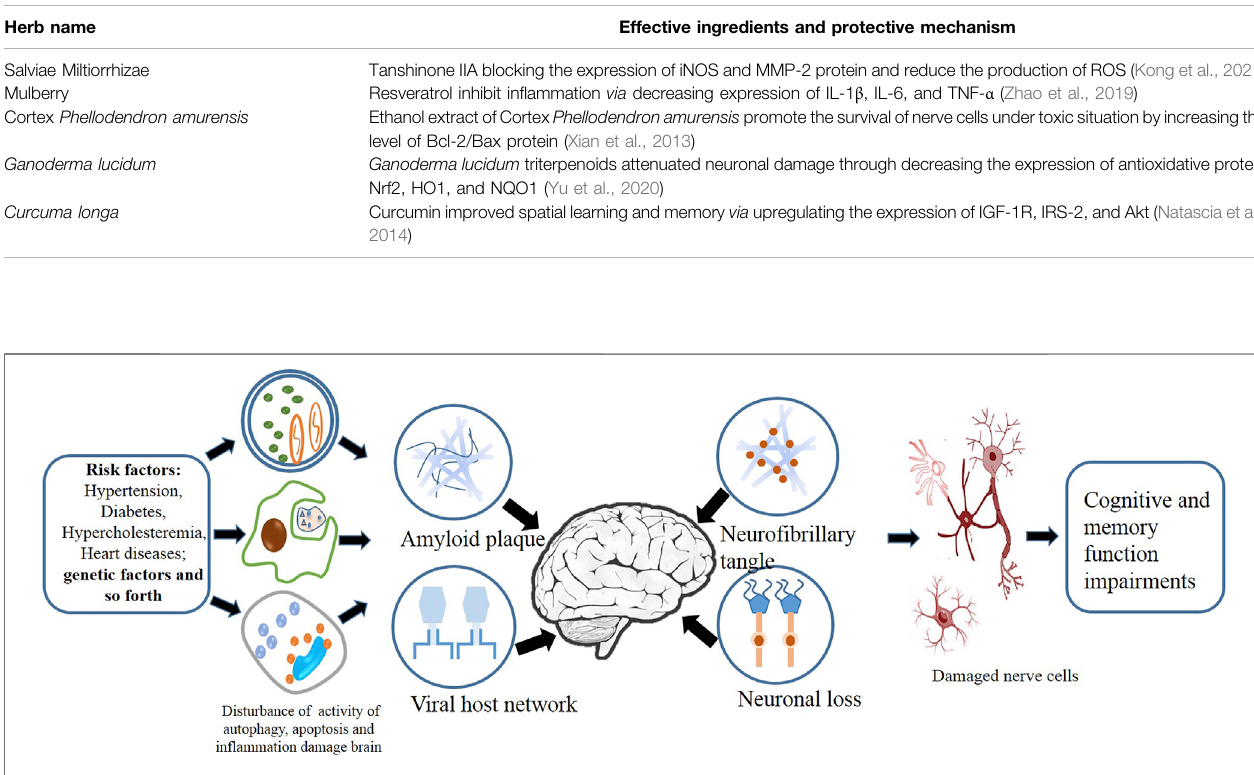
Frontiers in Pharmacology |